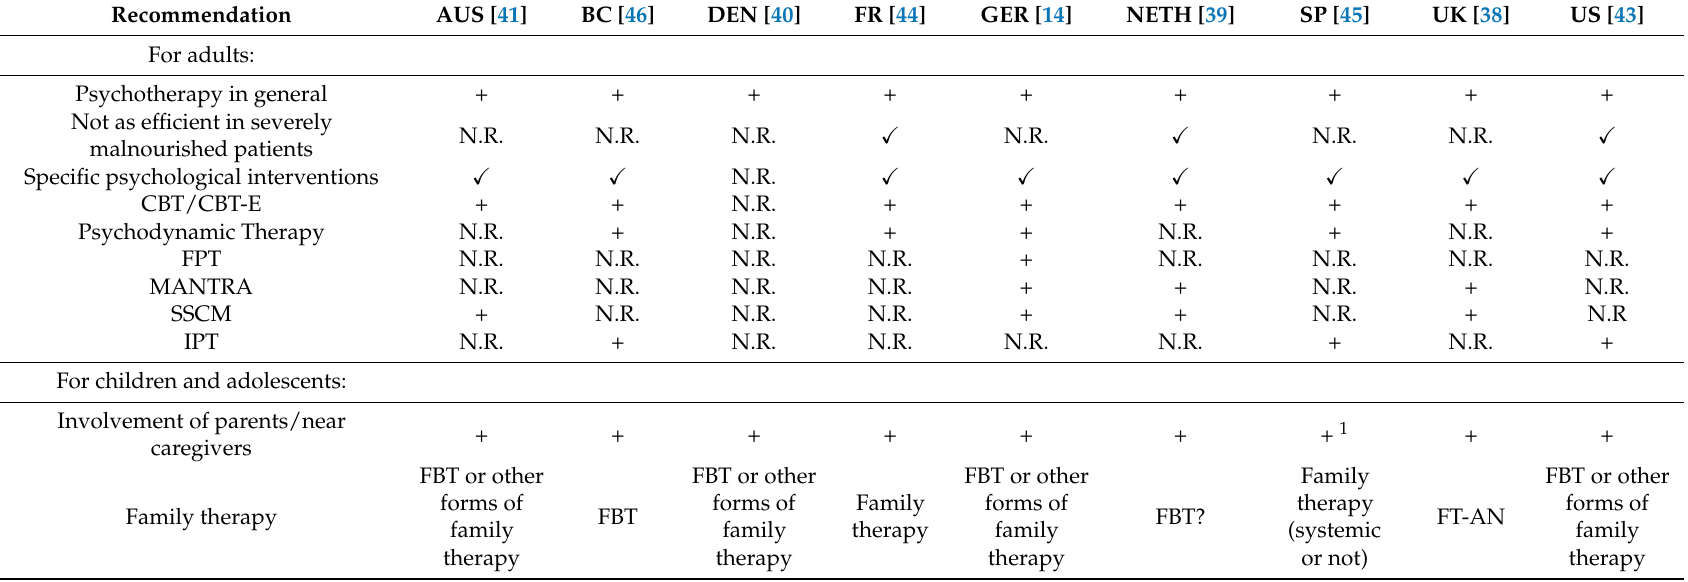
Table 2. International guidelines’ key recommendations regarding psychotherapy for AN. Recommendation